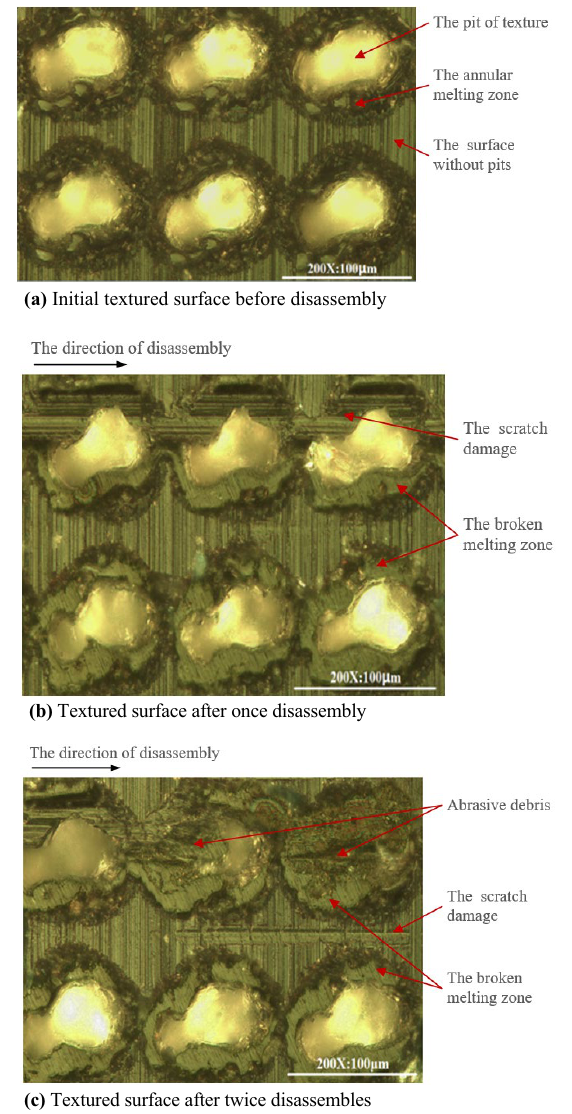
Figure 13 Microphotograph of the excellent textured surface before and after